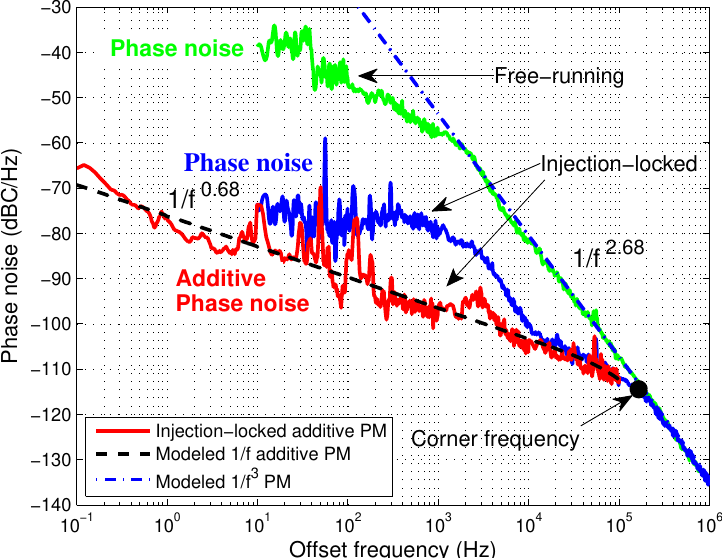
Figure 10. Comparison of additive phase noise S φ , add and phase noise S φ for the pHEMT oscillator with Load Circuit 2 operating at 2.485